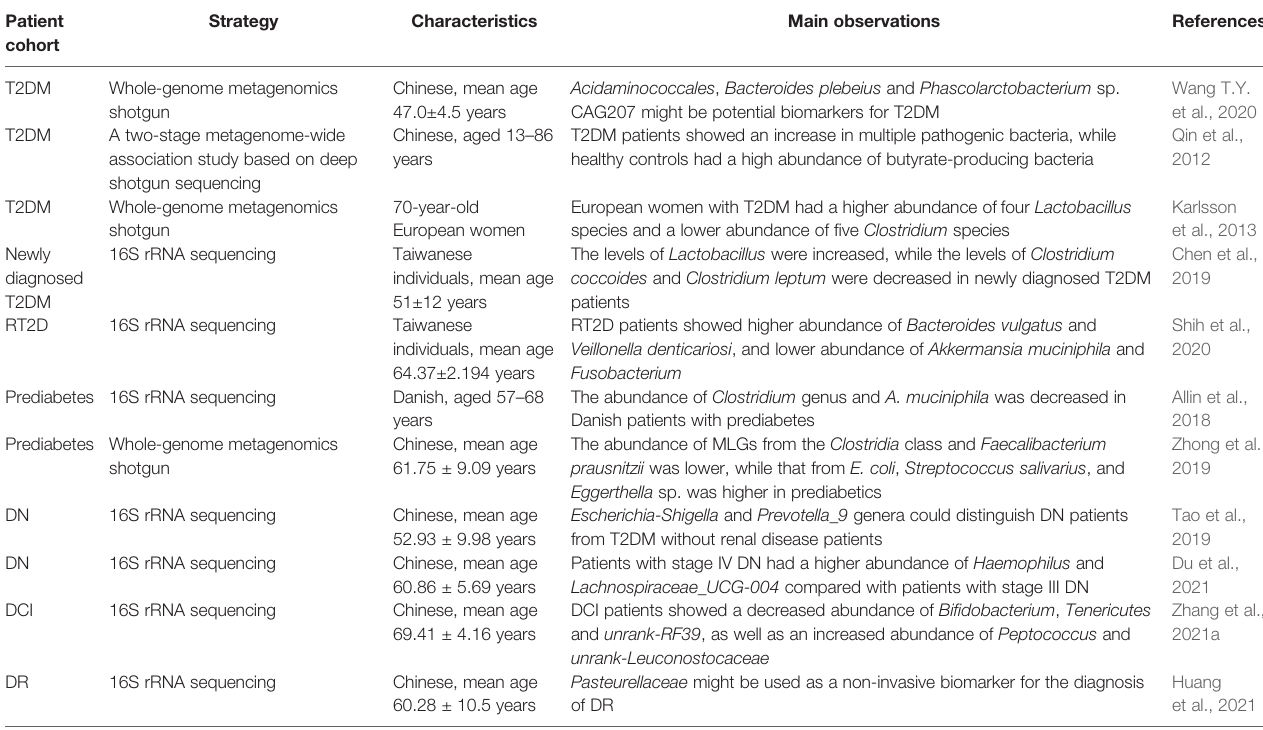
TABLE 1 | Major fi ndings from the studies of patients with